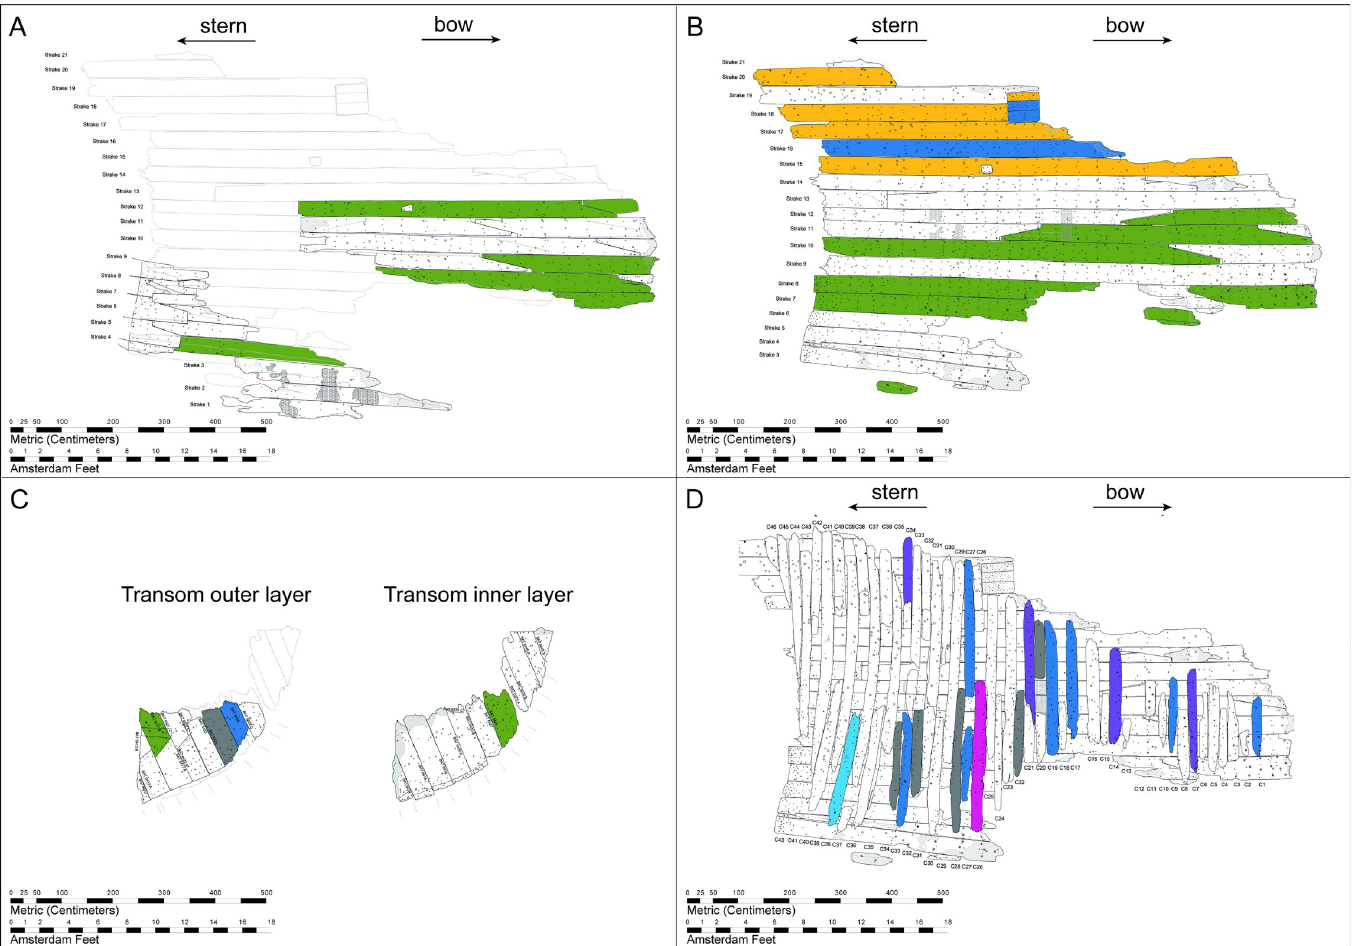
Fig 5. Distribution of the dated timbers in some parts of the shipwreck, coloured by provenance. A) Inner hull planks; B) Outer hull planks; C) Transom planks; D) Framing elements.